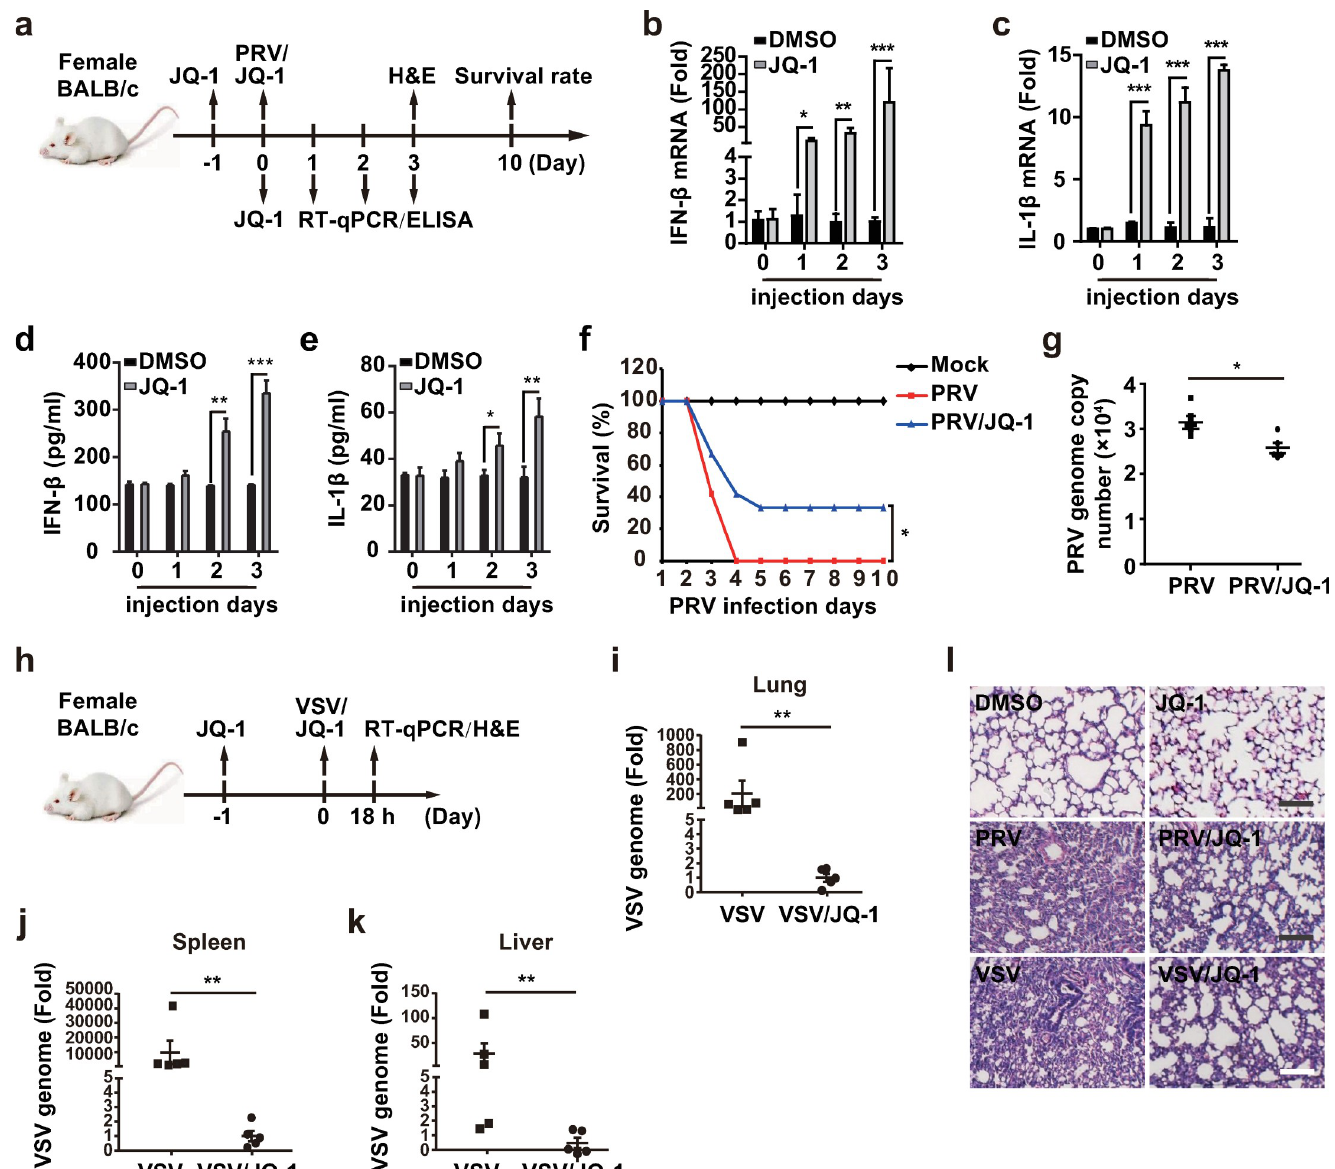
per group). (f) The survival rate was monitored daily for 10 days after PRV and PRV/JQ-1 challenge. (n = 12 per group). (g) The PRV genome was assessed with RT- qPCR analysis in the lungs of mice at 3 days post treatment of PRV and PRV/JQ-1 (n = 5 per group). (h) Experimental strategy for VSV-GFP challenge and JQ-1 treatment in mice. (i-k) The VSV genome was assessed with RT-qPCR analysis in the lung (i), spleen (j) and liver (k) of mice at 18 h post treatment of VSV and VSV/ JQ-1 (n = 5 per group). (l) H&E stained images of lungs sections from mice treated as in g and i. Scale bar, 100 μ M. All data are shown as mean ± SD based on three independent experiments. � P < 0.05, �� P < 0.01, ��� P < 0.001 determined by two-tailed Student’s t